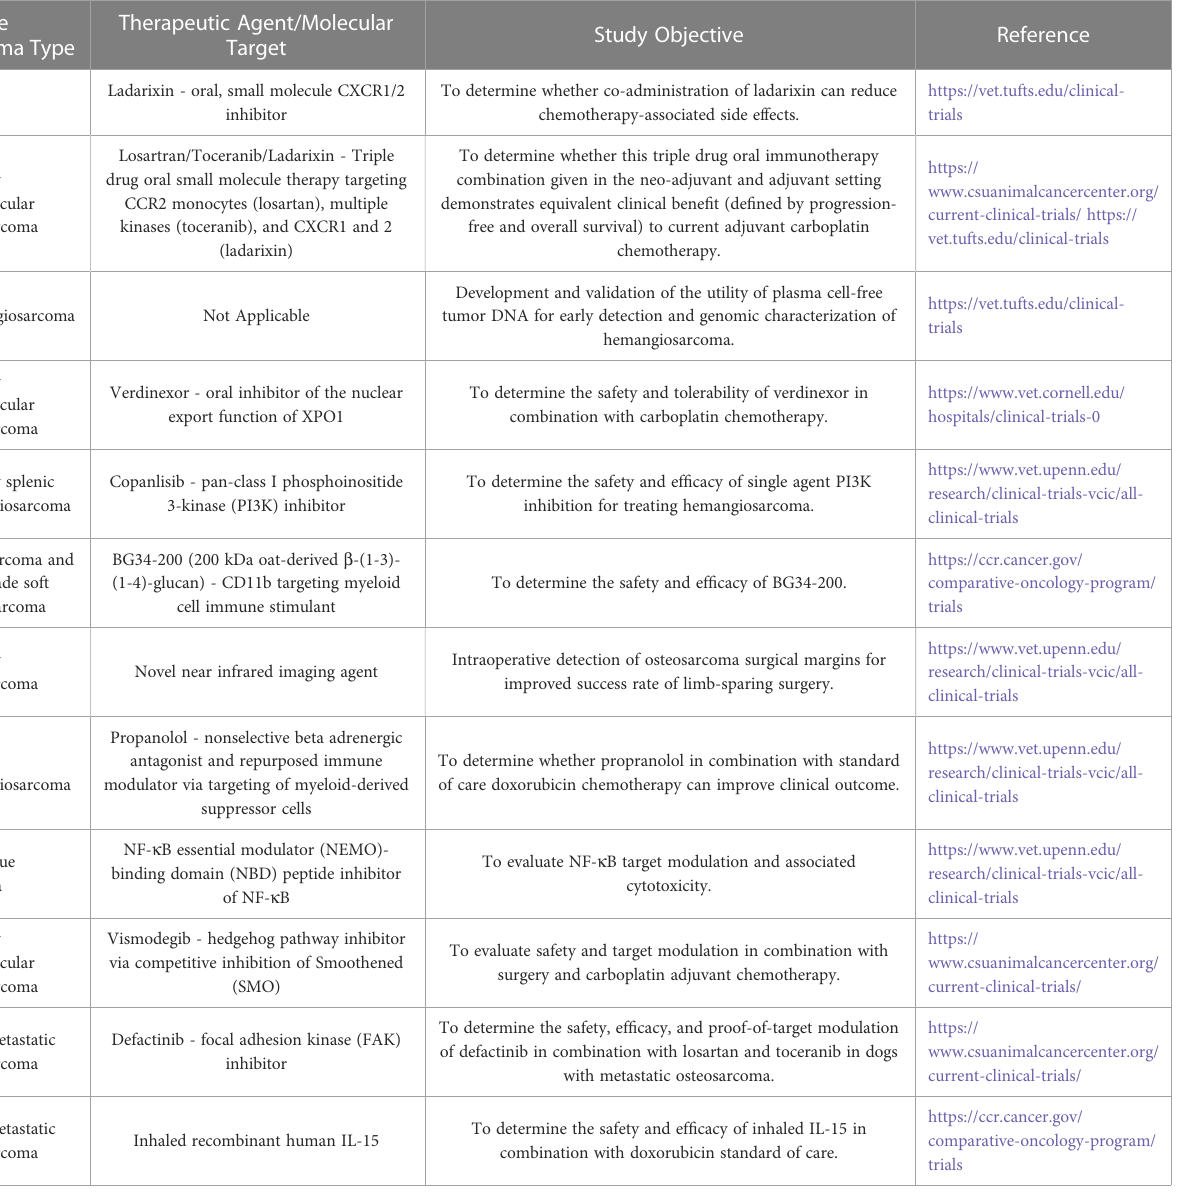
TABLE 1 Ongoing canine sarcoma trials that can inform human studies. Canine Sarcoma